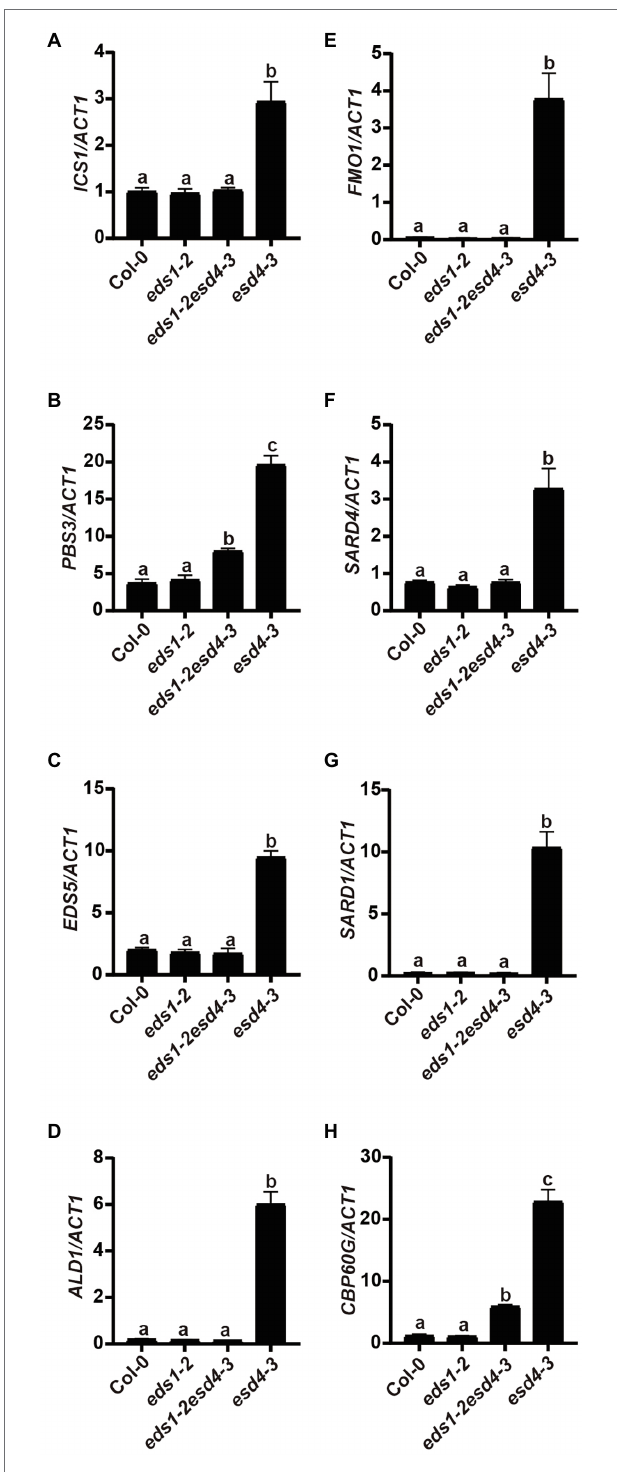
FIGURE 6 | Elevated SA and NHP biosynthetic genes in esd4 are reduced by eds1 . qRT-PCR was used to examine the SA biosynthesis genes (A-C) , NHP biosynthesis genes (D-F) , SARD1 (G) and CBP60g (F) on three-week- old Col-0, eds1-2 , eds1-2esd4-3, and esd4-3 mutants. ACTIN1 serves as internal control. Error bars represent standard deviations. Letters indicate statistical differences ( p < 0.05, one-way ANOVA, n =